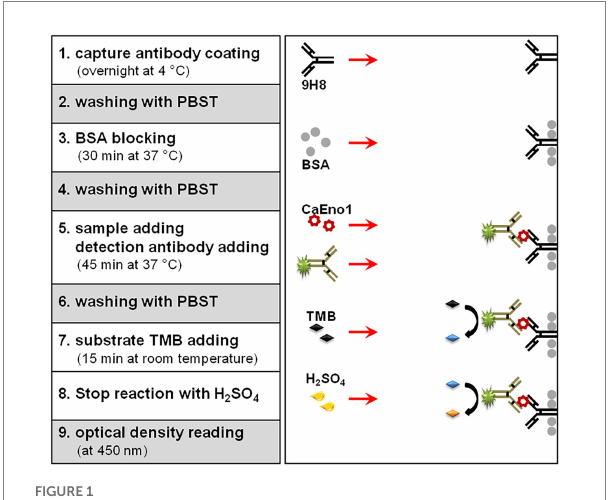
FIGURE 1 Schematic representation of the one-step double monoclonal antibody sandwich ELISA